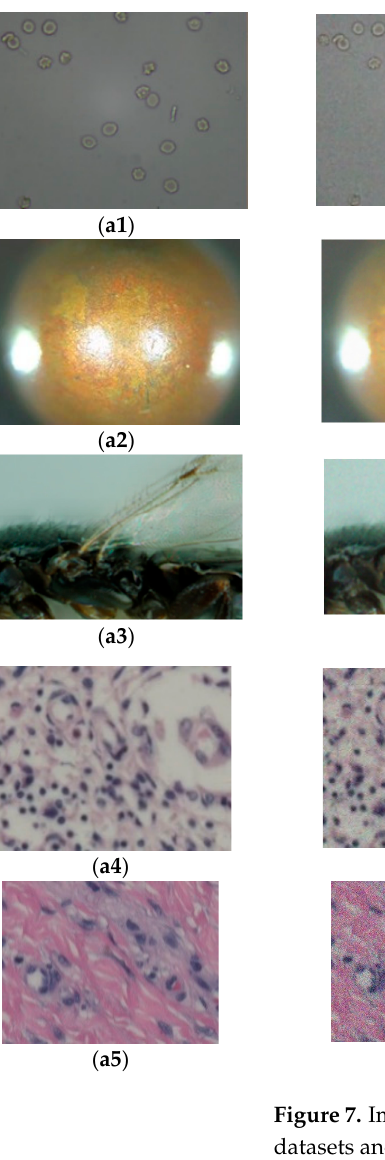
25 Picture number